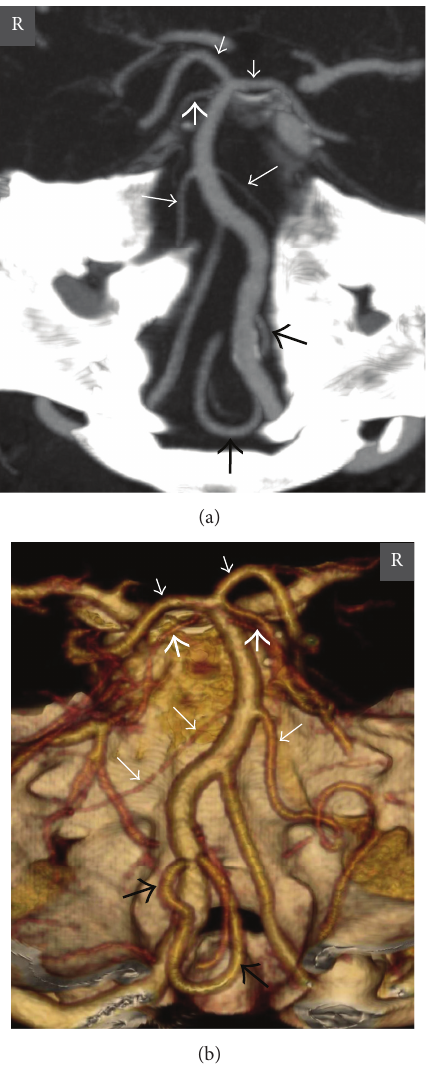
Figure 3: Oblique coronal view MIP (a) and posteroanterior view VR (b) computed tomography (CT) angiography images show absence of the right PICA and well-developed right AICA and left PICA in a 54-year-old man. The images also depict a dominant left vertebralartery. Thicklongarrow =leftPICA, thinlongarrows =right and left AICAs, thick short arrows = right and left SCAs, thin short arrows = right and left PCAs, and R =